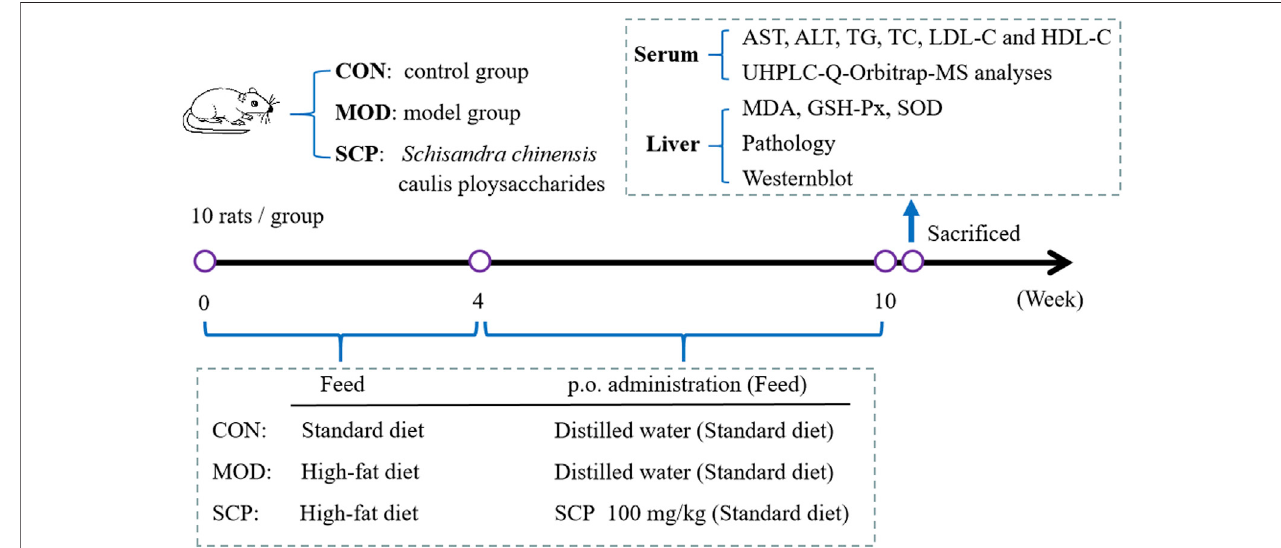
FIGURE 1 | Grouping and administration of rats and experimental processes.